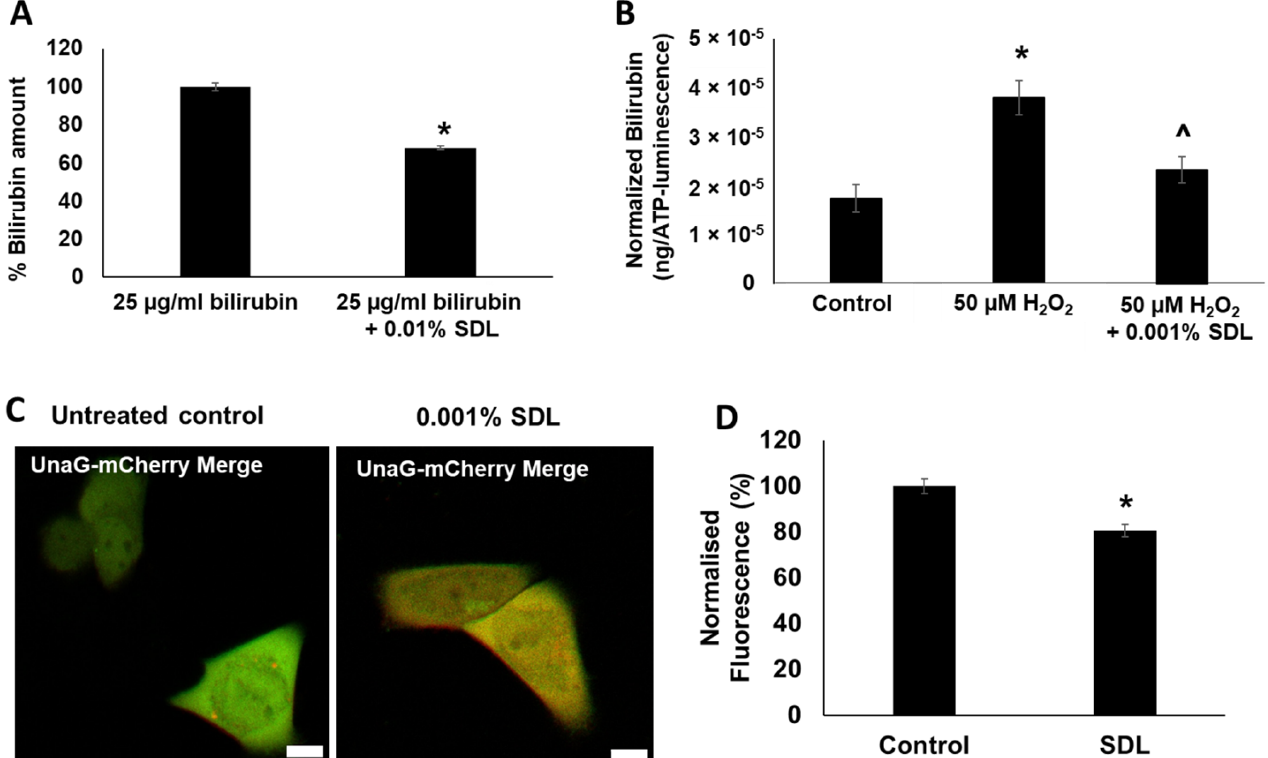
Figure 8. ( A ) Reduction of bilirubin concentration by incubation with 0.01% SDL for 20 h. Bar indicates mean ± SEM. n = 3/group. *; p < 0.05 vs. control. ( B ) Inhibitory effect of 0.001% SDL on H 2 O 2 -induced bilirubin production in keratinocytes at 48 h. Bilirubin concentrations were quantified using HPLC-MS method and were normalized to ATP level (an indicator of cell viability). Bar indicates mean ± SEM. n = 4/group. *; p < 0.05 vs. control. ^; p < 0.05 vs. 50 µM H 2 O 2 -treated group. ( C ) Visualization of bilirubin production by using UnaG-mCherry bilirubin sensor in keratinocytes in absence or presence of 0.001% SDL for 48 h. Scale = 10 µm. ( D ) Calculated green fluorescence intensity (bilirubin) normalized to red fluorescence intensity (mCherry). Bar indicates mean ± SEM. n = 13/group. *; p < 0.01.